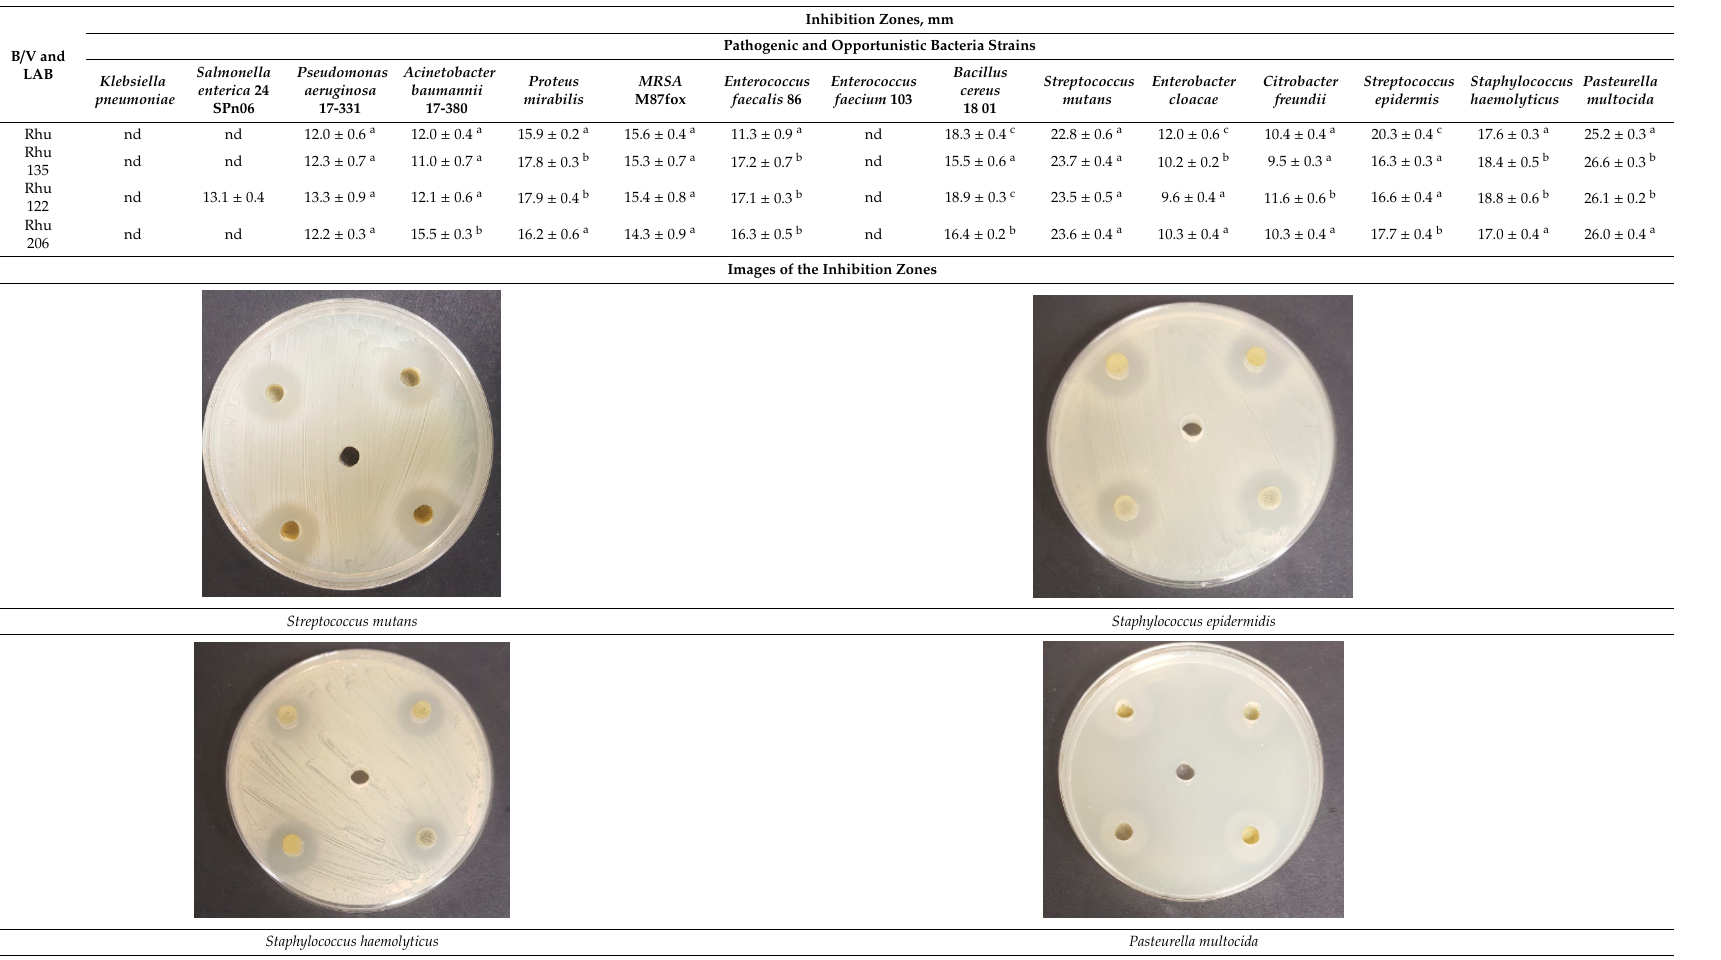
Table 5. Inhibition zones (mm) of pure rhubarb pomace and beverages against pathogenic opportunistic microorganisms.